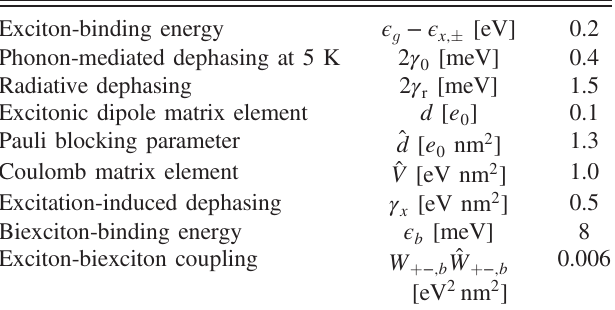
TABLE II. Excitonic parameters for a monolayer of MoS 2 encapsulated in hexagonal boron